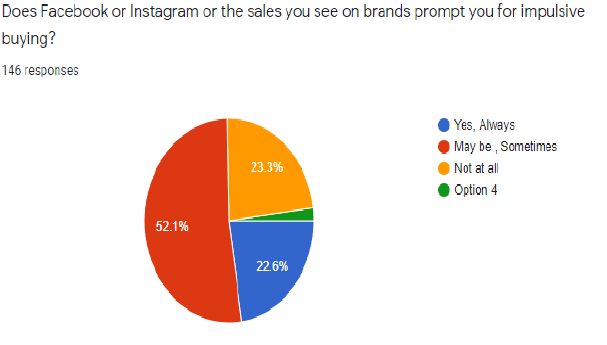
Figure 3. Impulsive buying behavior of the consumer